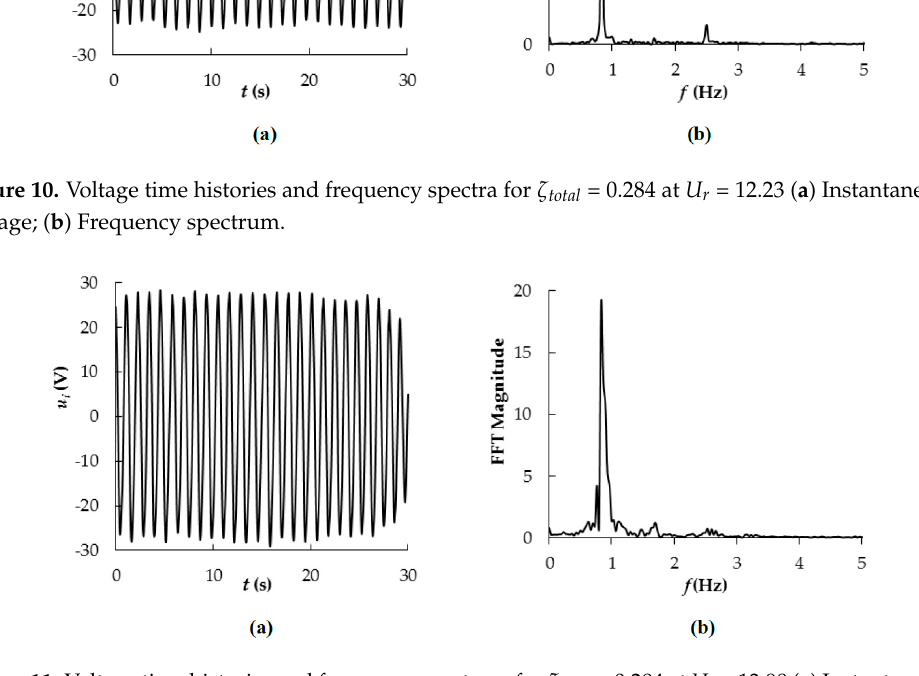
Figure 11. Voltage time histories and frequency spectrum for ζ total = 0.284 at U r = 13.98 ( a ) Instantaneous voltage; ( b ) Frequency spectrum.